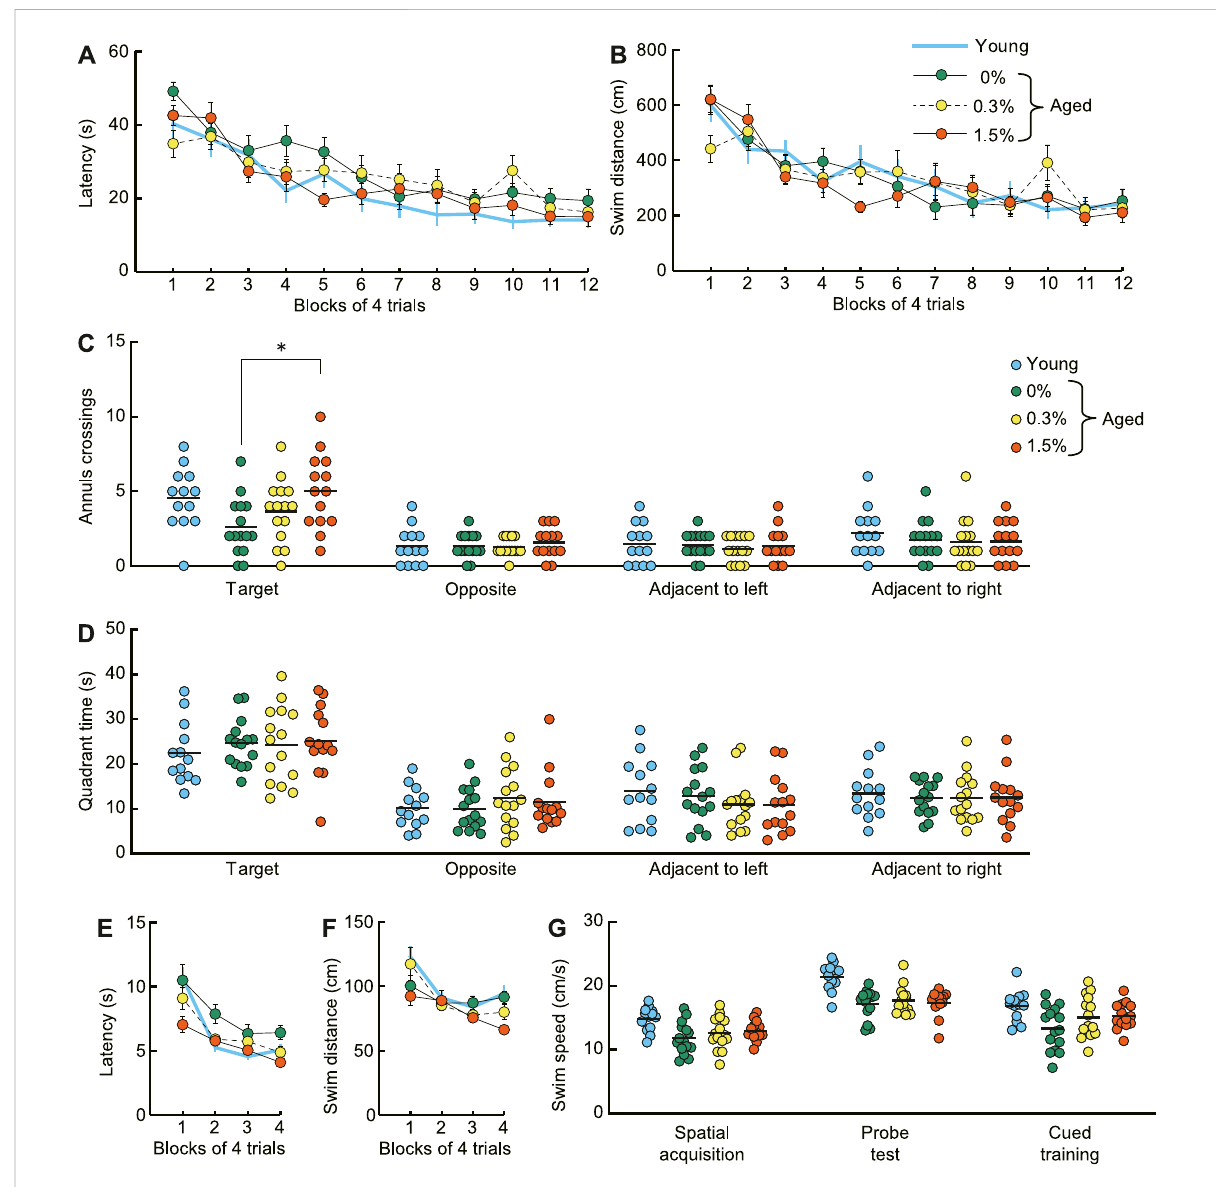
FIGURE 5 Cilostazol improves spatial memory and cued learning of aged mice in the Morris water maze. (A) Mean escape latency and (B) mean swim distance to thesubmergedplatform decreased at asimilar rate during acquisitiontraining. Two-way ANOVA showed that performance over 12 days of acquisition training was similar for the three dosage groups of aged mice. (C) Scatter dot plotrepresenting number of platform crossings (annulus crossings) during the probe test, which was conducted 1 day after the completion of spatial acquisition training. The 1.5% dosage group made signi fi cantly greater number of swimming traverses over the previous platform position than that of the control (0%) mice ( p < 0.05). (D) Scatter dot plot of time spent in the training quadrant during the probe test. Mean time spent swimming in the training quadrant during the probe was similar among the different cilostazol dosage groups. (E) Mean escape latency and (F) mean swim distance to the visible platform during the visual cued training in the Morris water maze. The 1.5% cilostazol group had signi fi cantly faster escape latency than control (0% cilostazol) aged mice ( p < 0.01). The 1.5% dosage group also had shorter swim distances, however, this difference was marginally signi fi cant ( p = 0.103). (G) Scatter dot plot representing swim speed during acquisition training, probe test, and cued training. The swimming speed was equivalent among the three dosage groups throughout the task. For (A – G) , 0%, 0.3%, and 1.5% represent the concentration of orally administered cilostazol. Performance of 3-month- old young mice (Young) is shown as a reference but not included in statistical analyses. * p < 0.05 compared with the control mice. Error bars in (A,B,E,F) indicate S.E.M. Horizontal bars in (C,D,G) indicate mean